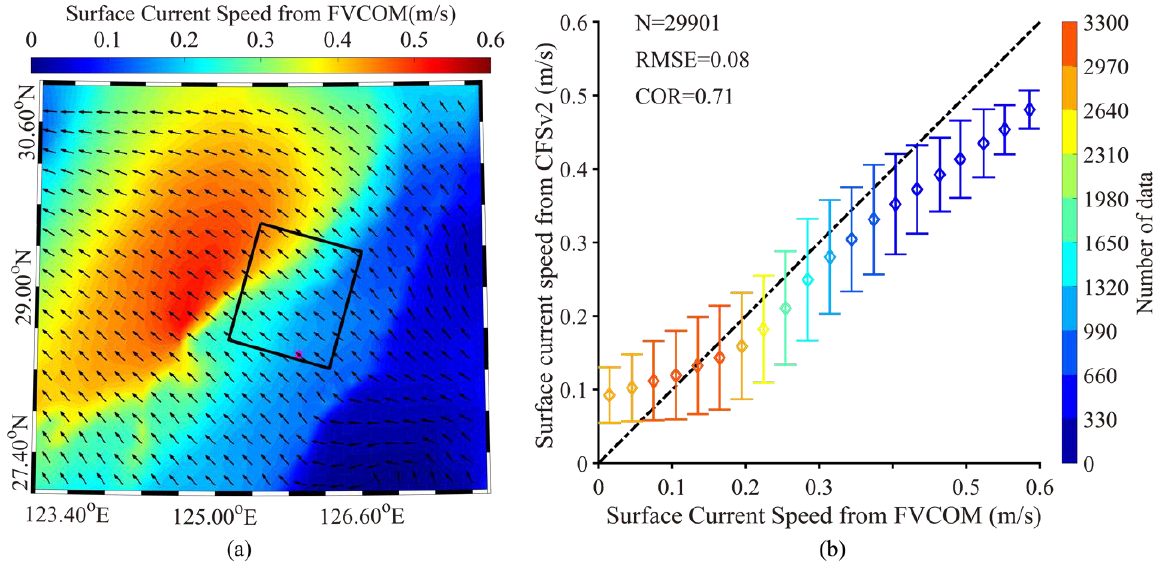
Figure 5. ( a ) The sea-surface current map from FVCOM taken on 14 January at 22:30, in which the black rectangle represents the spatial coverage of the corresponding GF-3 SAR image and the pinkish marks represent the shipwreck position; ( b ) The comparison between sea-surface current speeds simulated by the FVCOM and the CFSv2 data for a 0.03-m/s bin, in which the error bars represent the standard deviations of each bin for the matchups in the black rectangle in Figure 3.